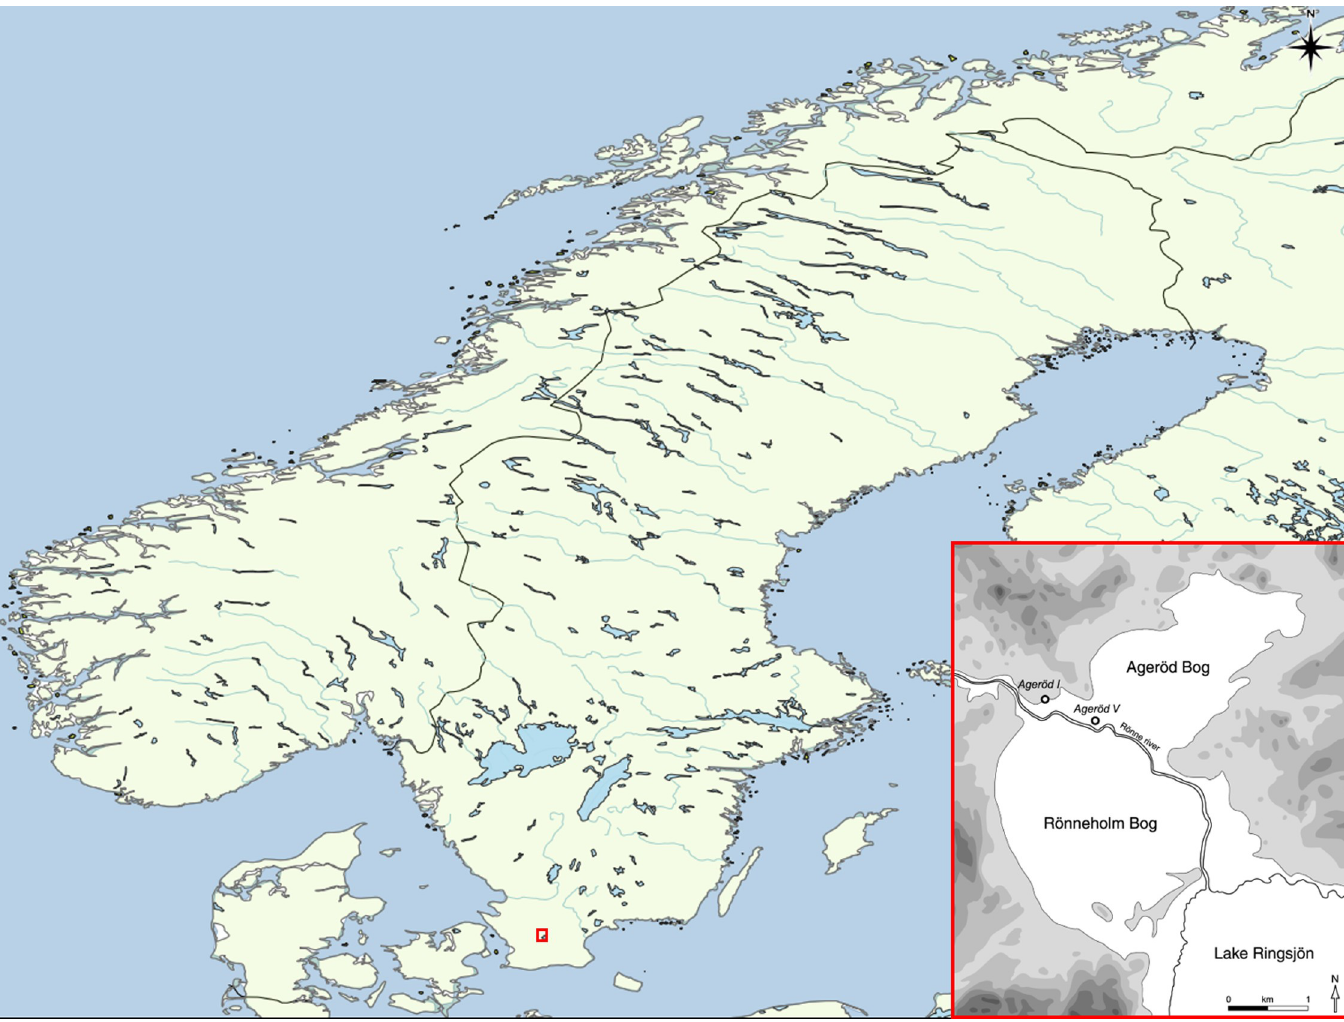
Fig 1. Map of Scandinavia zoomed in on the area of the Agero¨d I site located on the ancient shore of the former shallow lake. World map generated with QGIS 3.10 using the Natural Earth data set. Lower right drawing of the Agero¨d area by Arne Sjo¨stro¨m. Image created for this